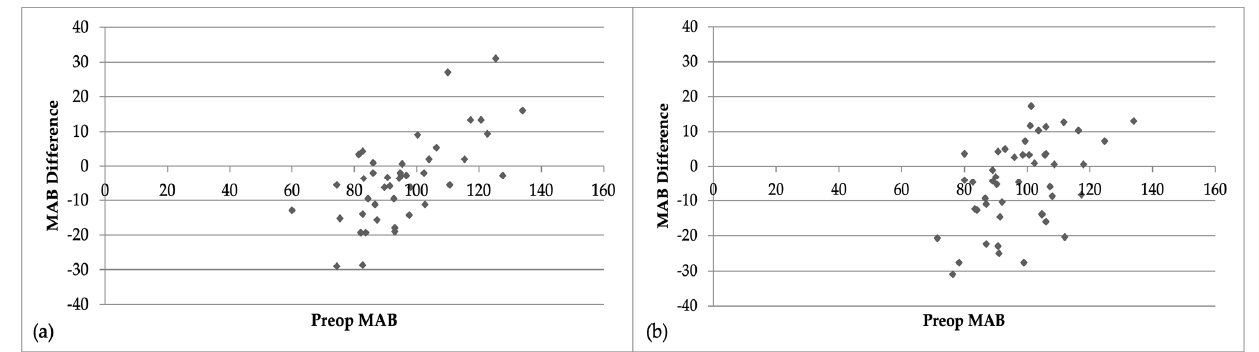
Figure 1. Bland Altman plots for mean arterial blood pressure (MAB) pre-operatively versus the difference [MAB pre-op minus MAB post-op] for ( a ) propofol group (R2 = 0.17, p = 0.003) and ( b ) the no propofol group (R2 = 0.23, p = 0.001).